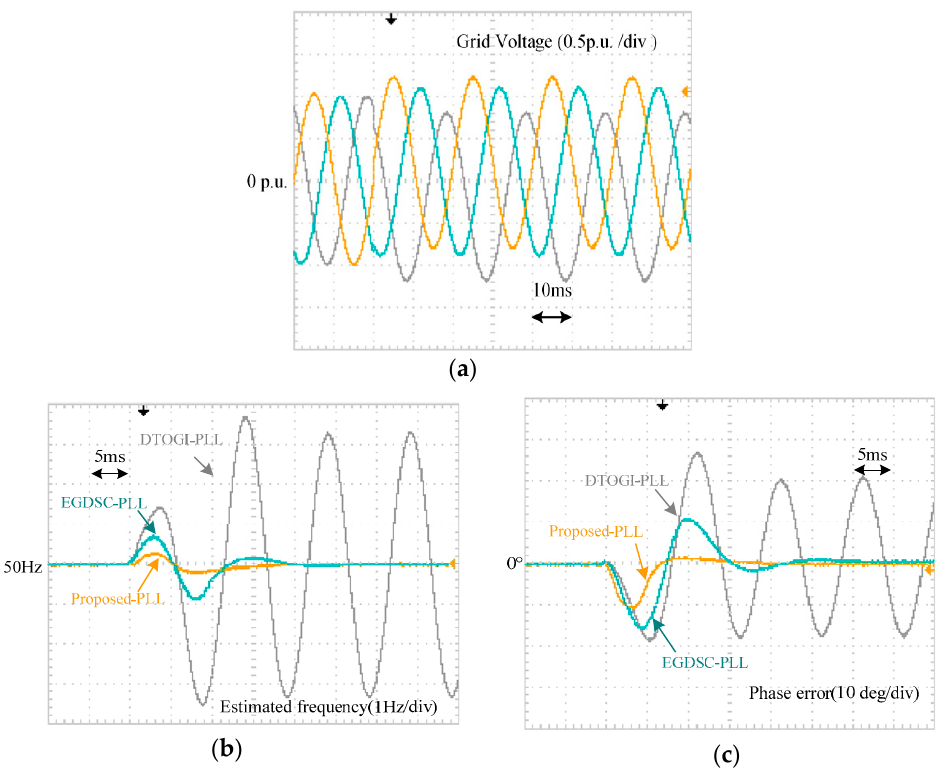
Figure 18. Experimental waveforms when the grid voltage is mixed with DC offset. ( a ) is the grid voltage waveform, ( b ) is the estimated frequency waveform, and ( c ) is the phase error waveform.